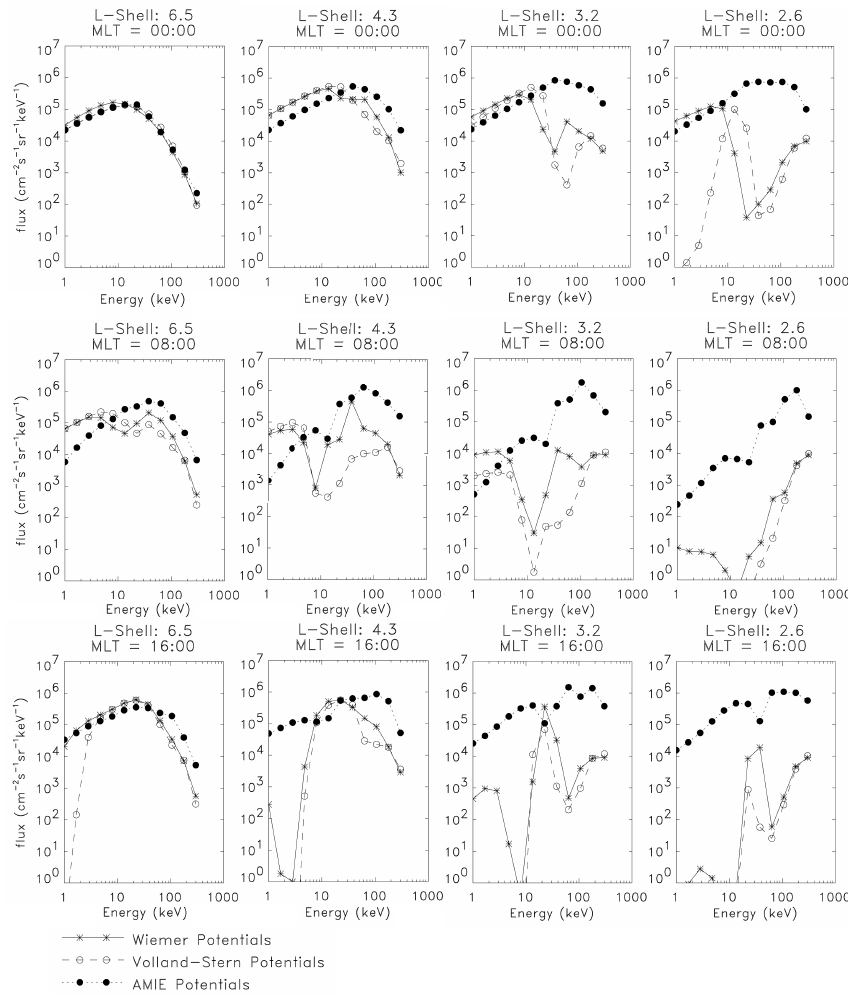
Fig. 6. Same as Fig. 5 except for protons at hour 80 (08:00 UT, end of the main phase).